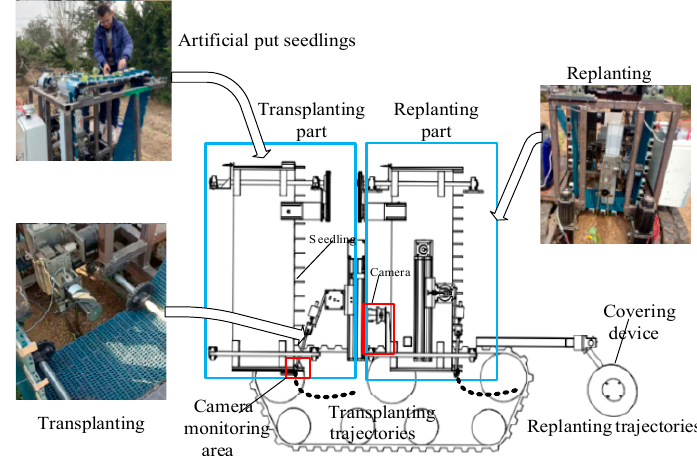
Figure 6. Work procedure.